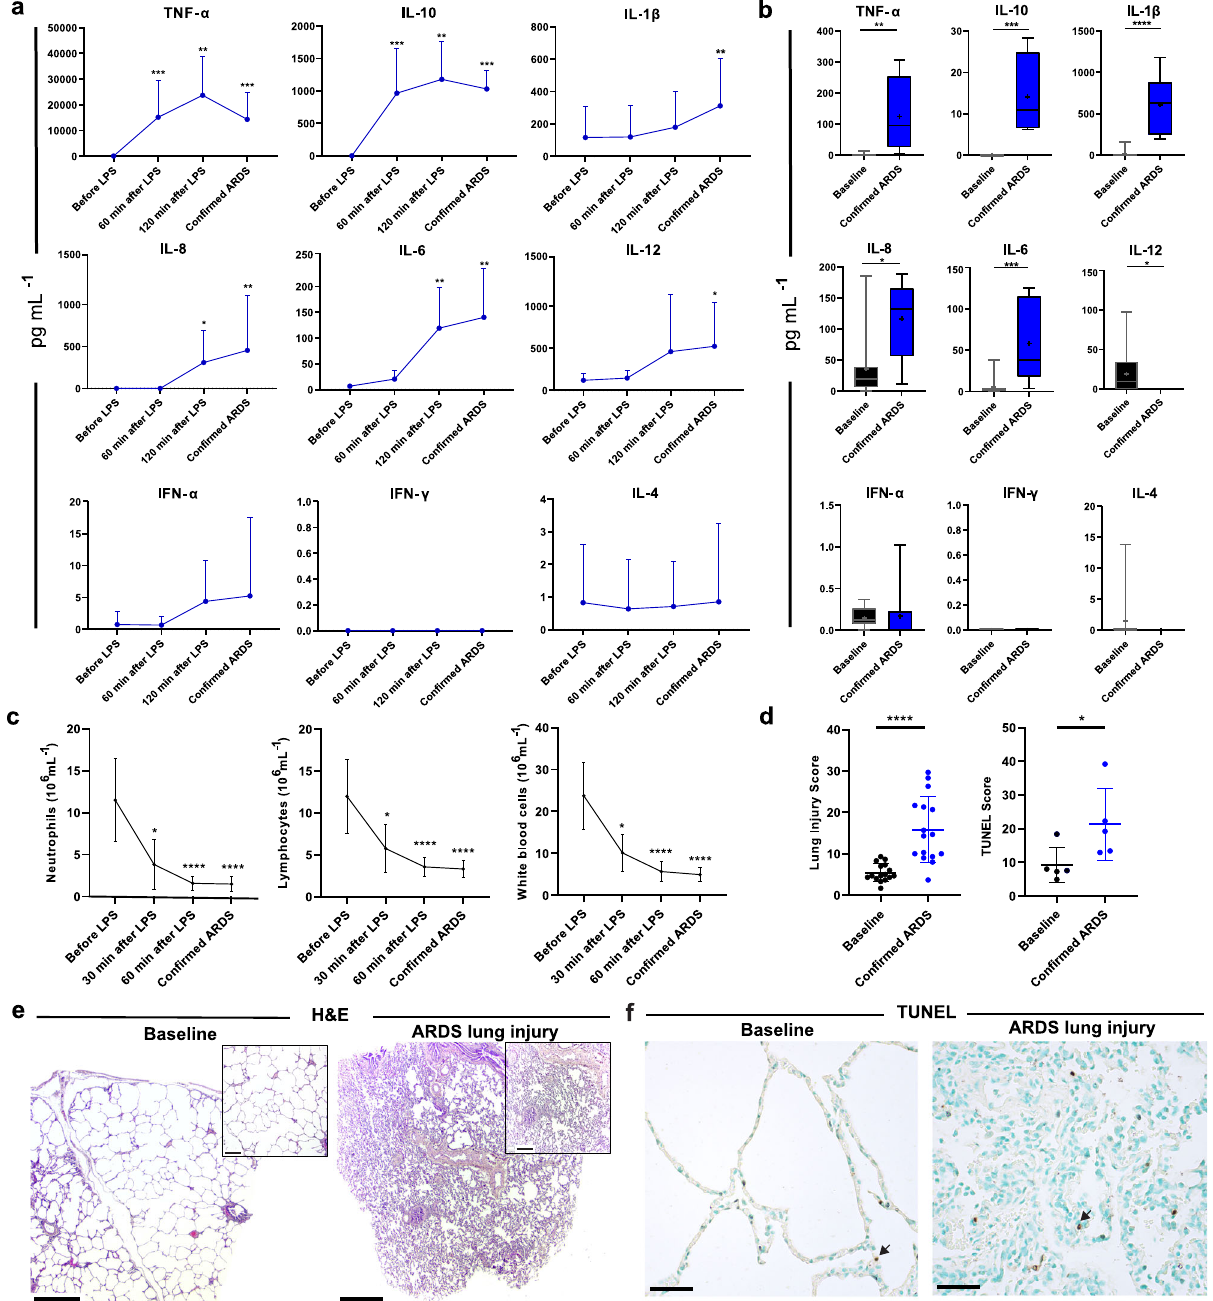
Fig. 2 Establishment of Acute Respiratory Distress Syndrome (ARDS) lung injury in the donor. ARDS was induced via lipopolysaccharide (LPS) administration and was con fi rmed via two blood gases taken at a 15-minute interval with values in accordance with the Berlin de fi nition of ARDS. a Cytokine measurement in plasma in the donor before LPS was administered and then 60 and 120 min after LPS was given ( n = 12). Cytokines were also measured in the plasma at the time of con fi rmed ARDS. b Cytokine measurement in bronchoalveolar lavage fl uid (BALF, n = 12). BALF was procured as a baseline measure before LPS administration and then again at con fi rmed ARDS, represented as a box-and-whiskers plot with a median line, a plus at the mean, and minimum and maximum values. c Neutrophils, lymphocytes, and white blood cell counts were recorded at baseline, 30 and 60 min after LPS, and at con fi rmed ARDS. d Scoring of lung injury of baseline biopsies and biopsies taken at pulmonary harvest after ARDS con fi rmation (left) and scoring of terminal deoxynucleotidyl transferase dUTP nick end labeling (TUNEL) positive cells/mm 2 (right). e Baseline (left) and ARDS lung injury (right) hematoxylin and eosin (H&E) staining. Scale bar in the larger image represents 0.5 mm. The callout shows a magni fi ed portion of the tissue where the scale bar represents 0.2 mm. f Representative images of TUNEL staining in baseline (top left) and injured lungs (bottom left) with representative black arrows indicating the type of positively stained cell counted. All graphs represent data from all donors ( n = 16) except TUNEL ( n = 5). Statistically signi fi cant differences between groups were tested with two-sided Student ’ s T -test and within groups with ANOVA when data were normally distributed. The two- sided Mann – Whitney test and the Kruskal – Wallis test were used when data were not normally distributed. * p < 0.05, ** p < 0.01, *** p < 0.001, **** p < 0.0001. All values represent the mean ± standard deviation unless otherwise stated.